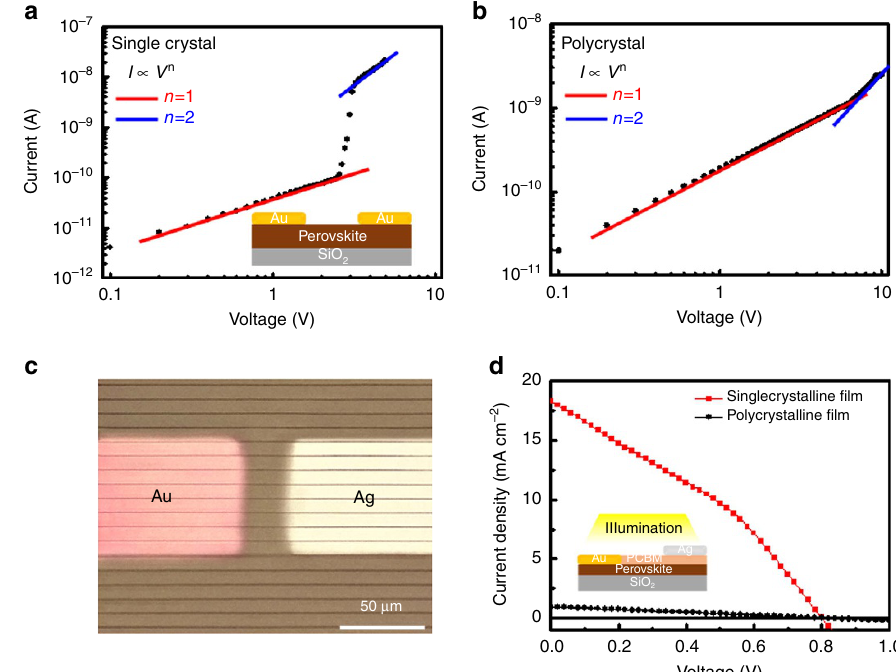
Figure 4 | Electrical properties of single-crystal perovskite thin films. ( a ) I–V curve of 200-nm-thick single-crystal perovskite patterned thin